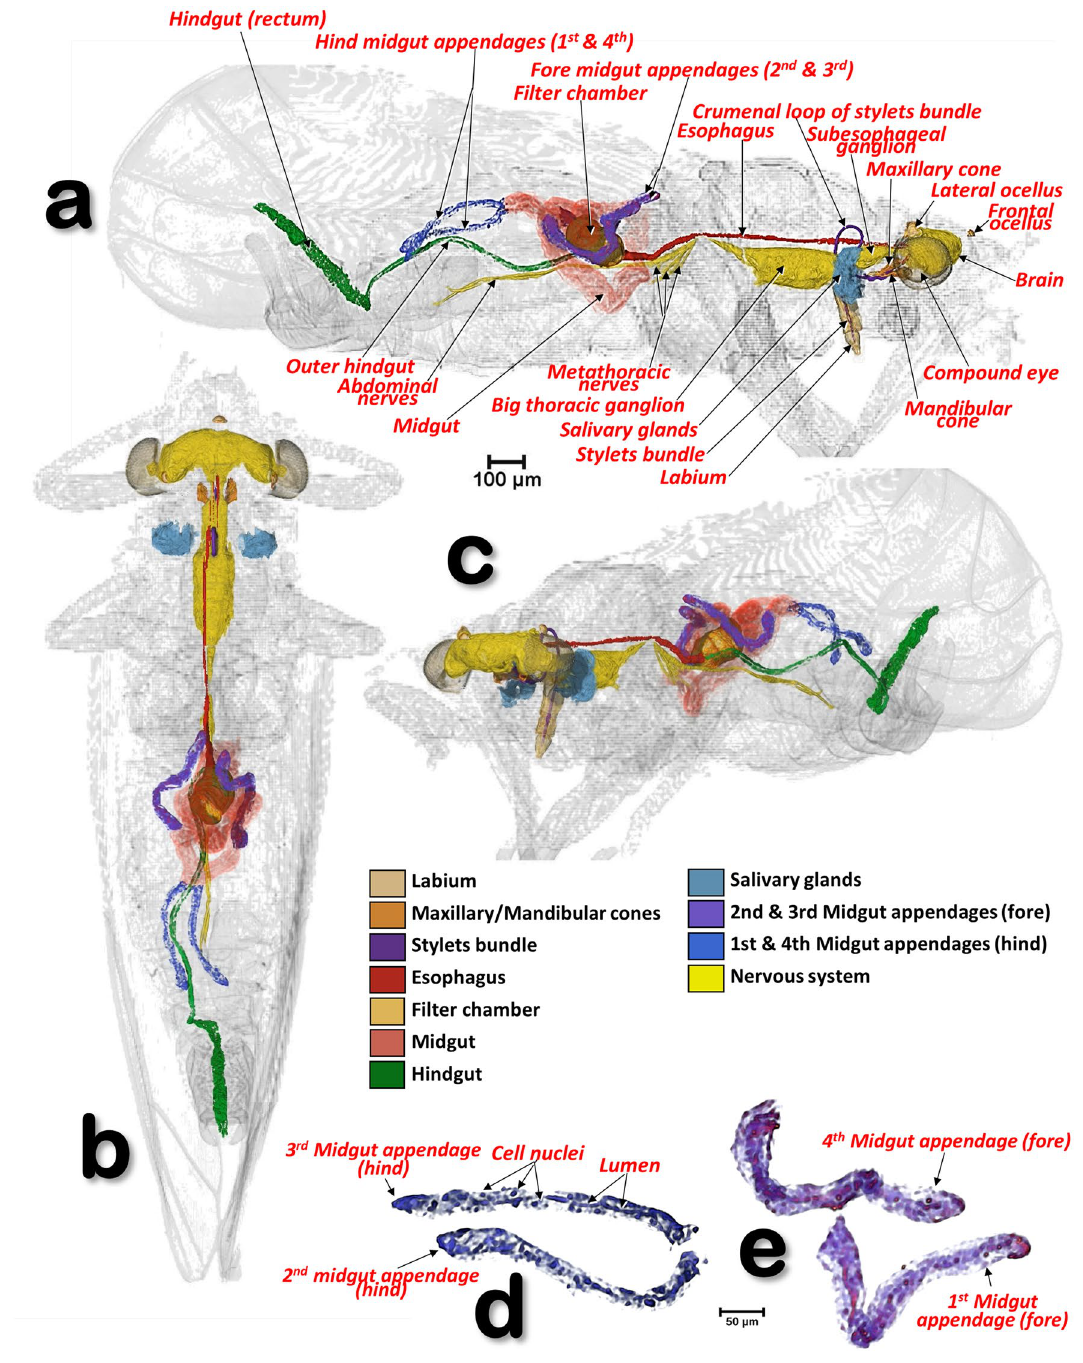
Figure 11. Volume-rendered images of a male Diaphorina citri showing the general position of the nervous system, and the digestive system (including the salivary glands), in different perspective views. Right-lateral ( a ), dorsal ( b ), and left-frontal ( c ). Details of the midgut appendages ( d , e